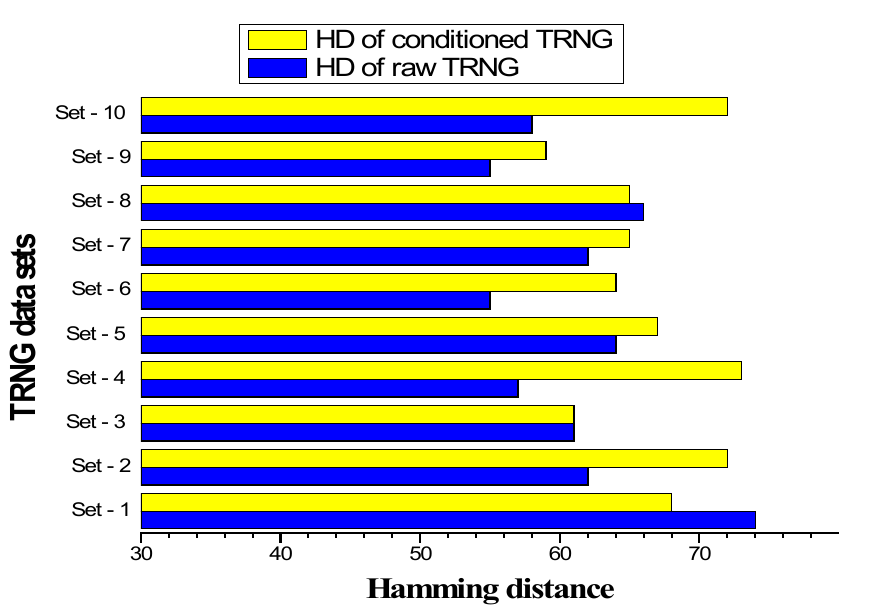
Figure 5. Average Hamming distance of the samples from the TRNG.